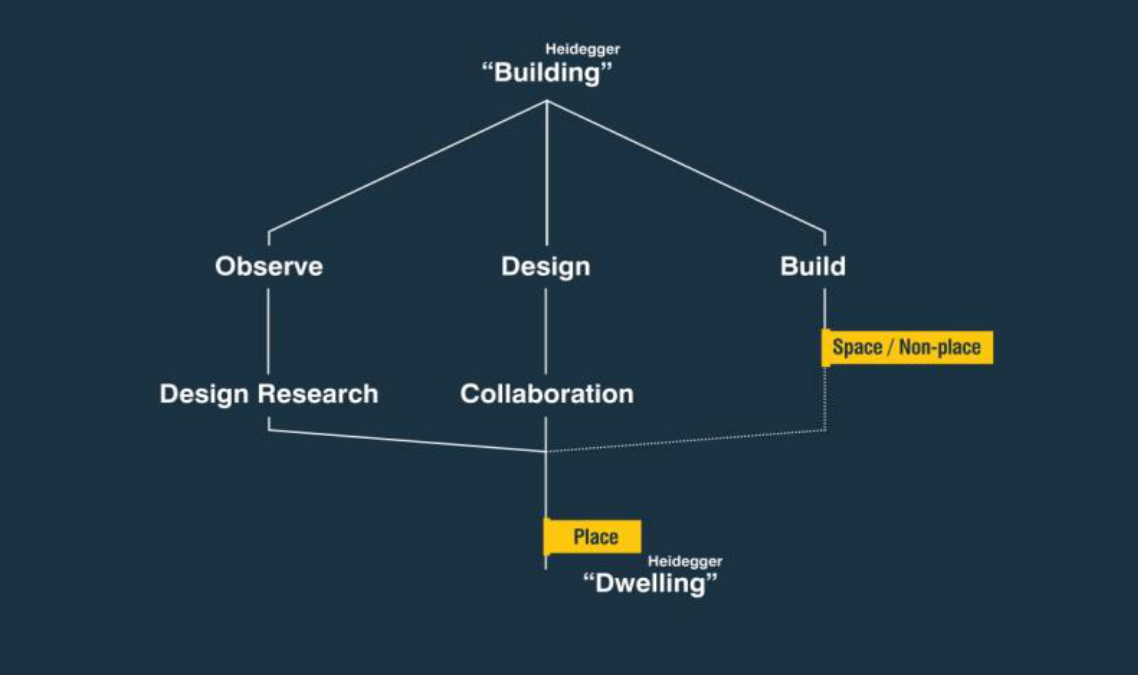
Figure 8. Diagrammatic exploration of Building as opposed to Dwelling (Author,